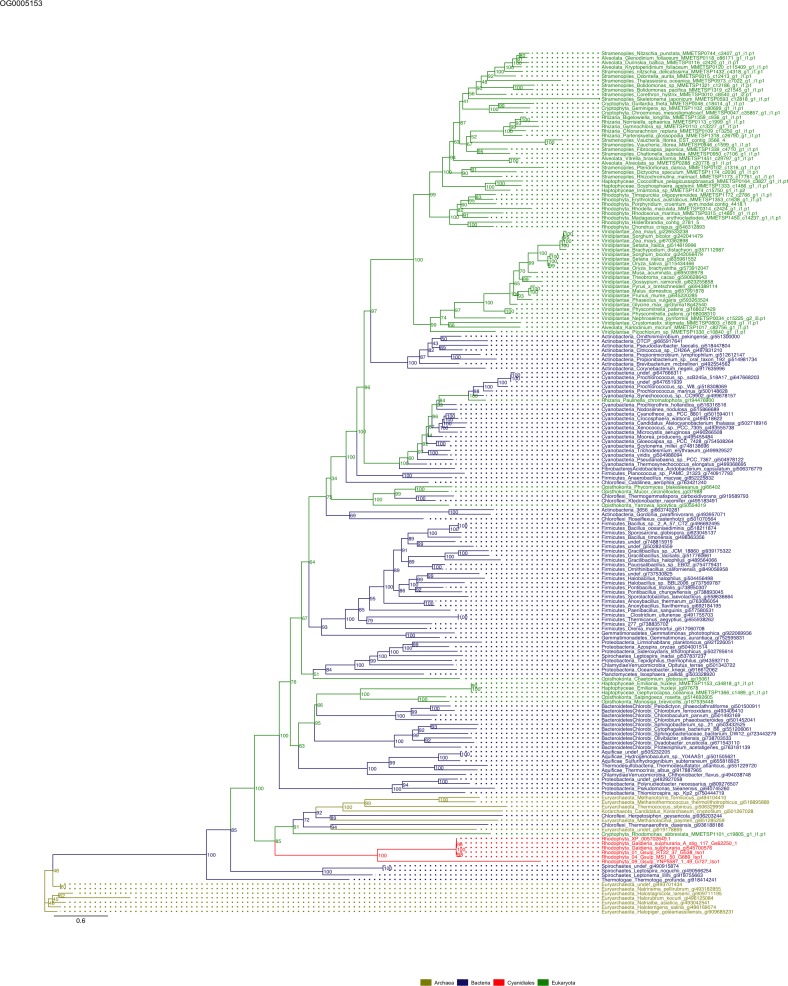
Sequence tree of orthogroup OG0005153.The tree is based on amino acid sequences. Archaea (yellow), Bacteria (blue), Cyanidiales (red), Eukaryotes including other red algae (green). Branches containing Cyanidiales sequences are highlited in red.